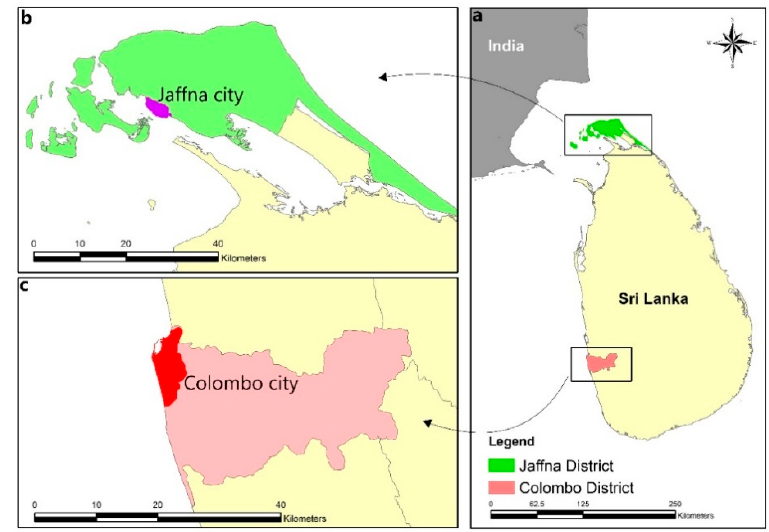
Figure 1. The map shows the ( a ) location of Sri Lanka in relation to India, ( b ) Jaffna city (purple colour) and Jaffna district in the Jaffna peninsula and ( c ) Colombo city (red colour) in the Colombo district.